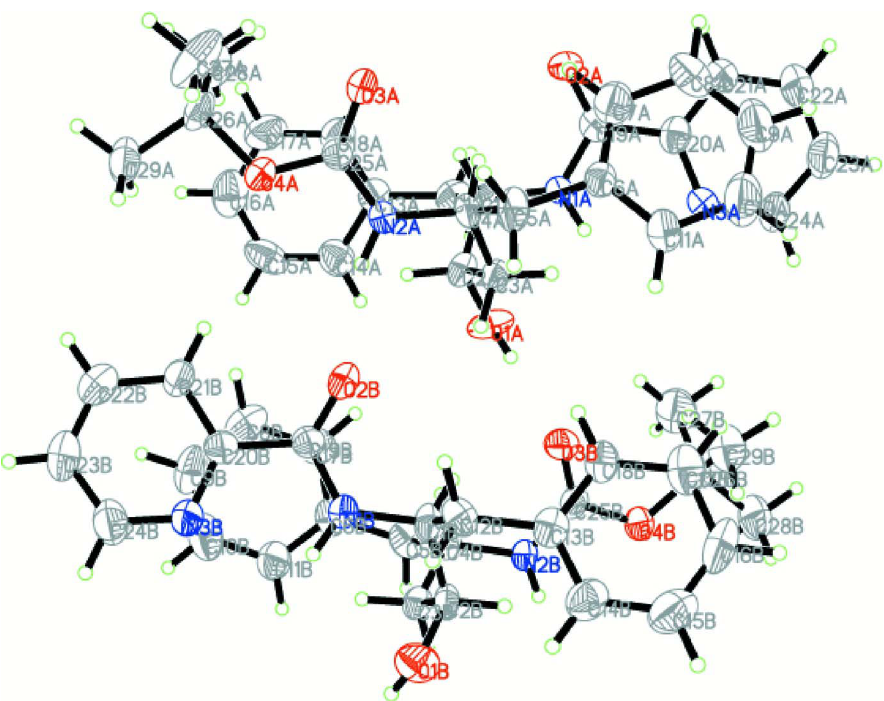
The asymmetric unit of (1) with the atom-labelling scheme, showing 50% probability displacement ellipsoids. H atoms are drawn as spheres of arbitrary